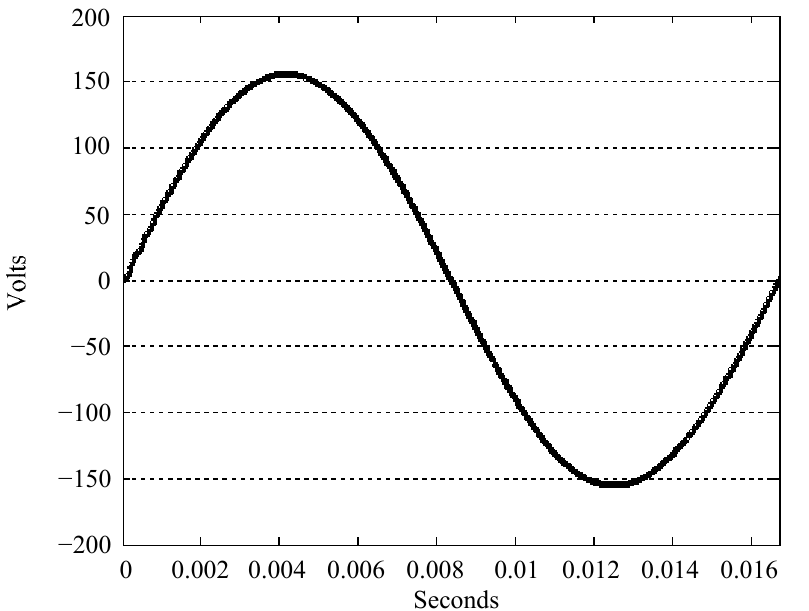
Figure 2. Simulated output voltage with the conventional SMC under full load.